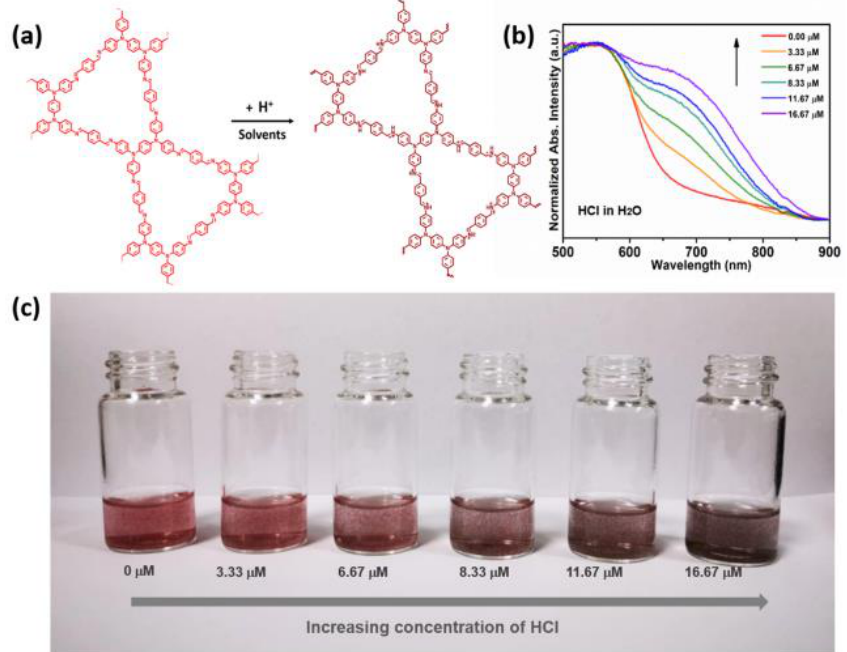
Figure 1. ( a ) Protonation process of TPBD-TA COF in acidic solutions, ( b ) solid-state absorption spectra of TPBD-TA COF in HCl aqueous solution, ( c ) color change of TPBD-TA COF in HCl aqueous solution with increased HCl concentration.